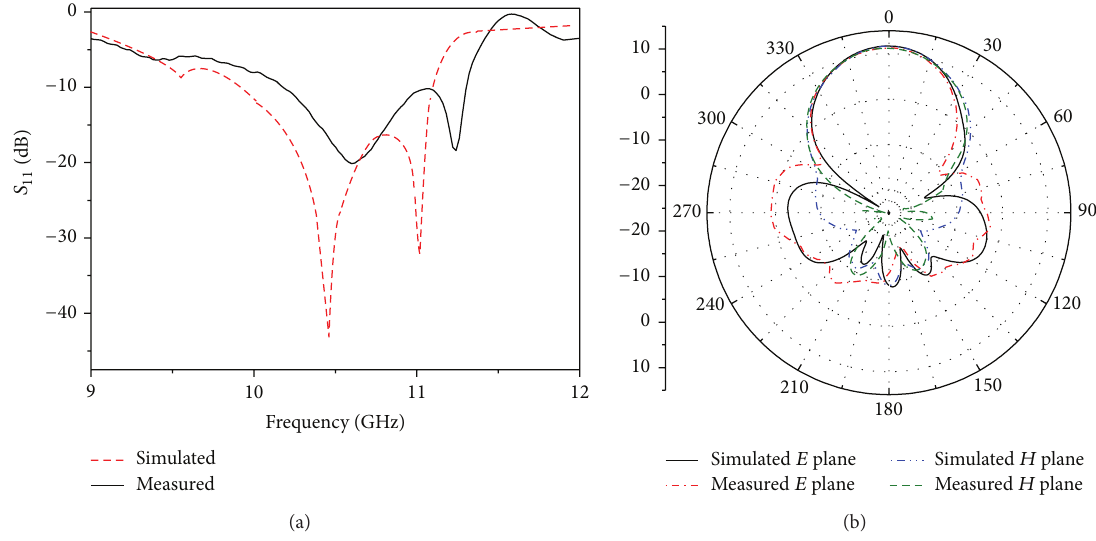
Figure 10: The performances of the proposed wideband antenna with the ZIM cover, (a) the reflection coefficients and (b) the radiation